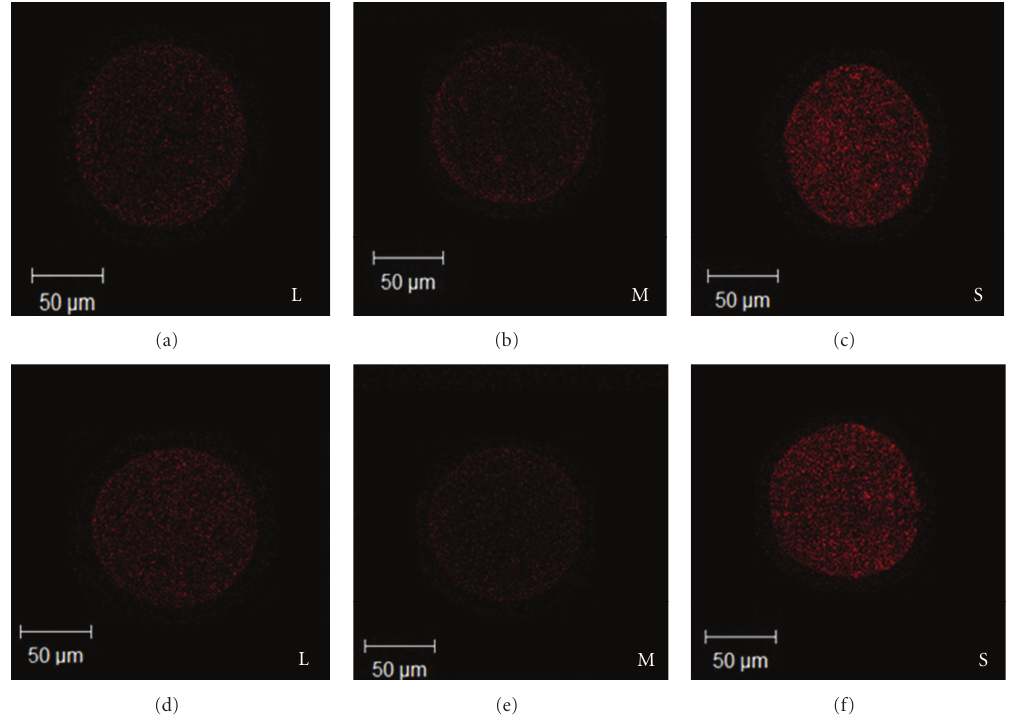
Figure 3: Confocal microscopic observation of INHB cellular distribution in porcine oocytes isolated from small, medium, and large follicles before and after IVM. Porcine oocytes isolated from small, medium, and large follicles were stained before and after IVM with porcine INHB (before IVM; (a), (b), and (c) and after IVM; (d), (e), and (f)), (rabbit polyclonal anti-INHB, sc-50288). The treated oocytes were labeled for 40min with TRITC (crystalline tetramethylrhodamine isothiocyanate), which emits a red fluorescent signal after excitation at 543 nm at